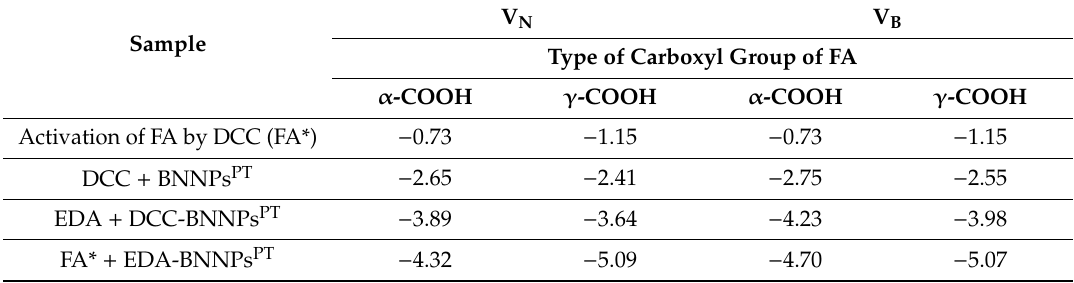
Table 4. The BE values (eV) for each reaction step during the fabrication of FA / EDA-BNNPs PT